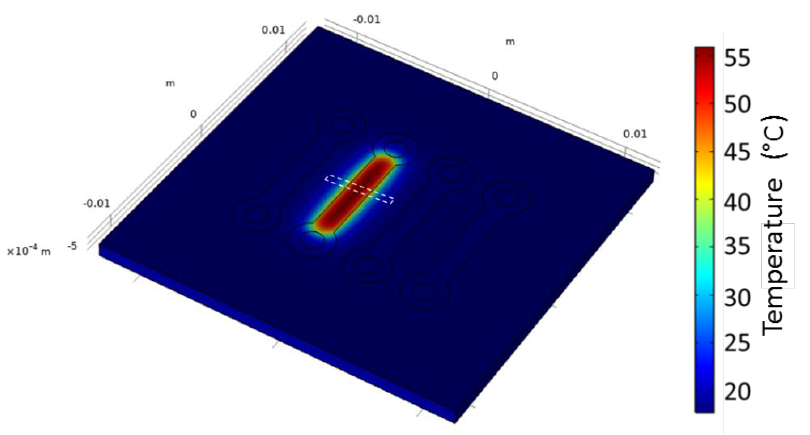
Figure 5. Typical 2D heatmap of sensor surface temperature under current injection (here, 300 mA). The white delimitation refers to the narrowed surface area that will be used in further modeling (see Figure 6).